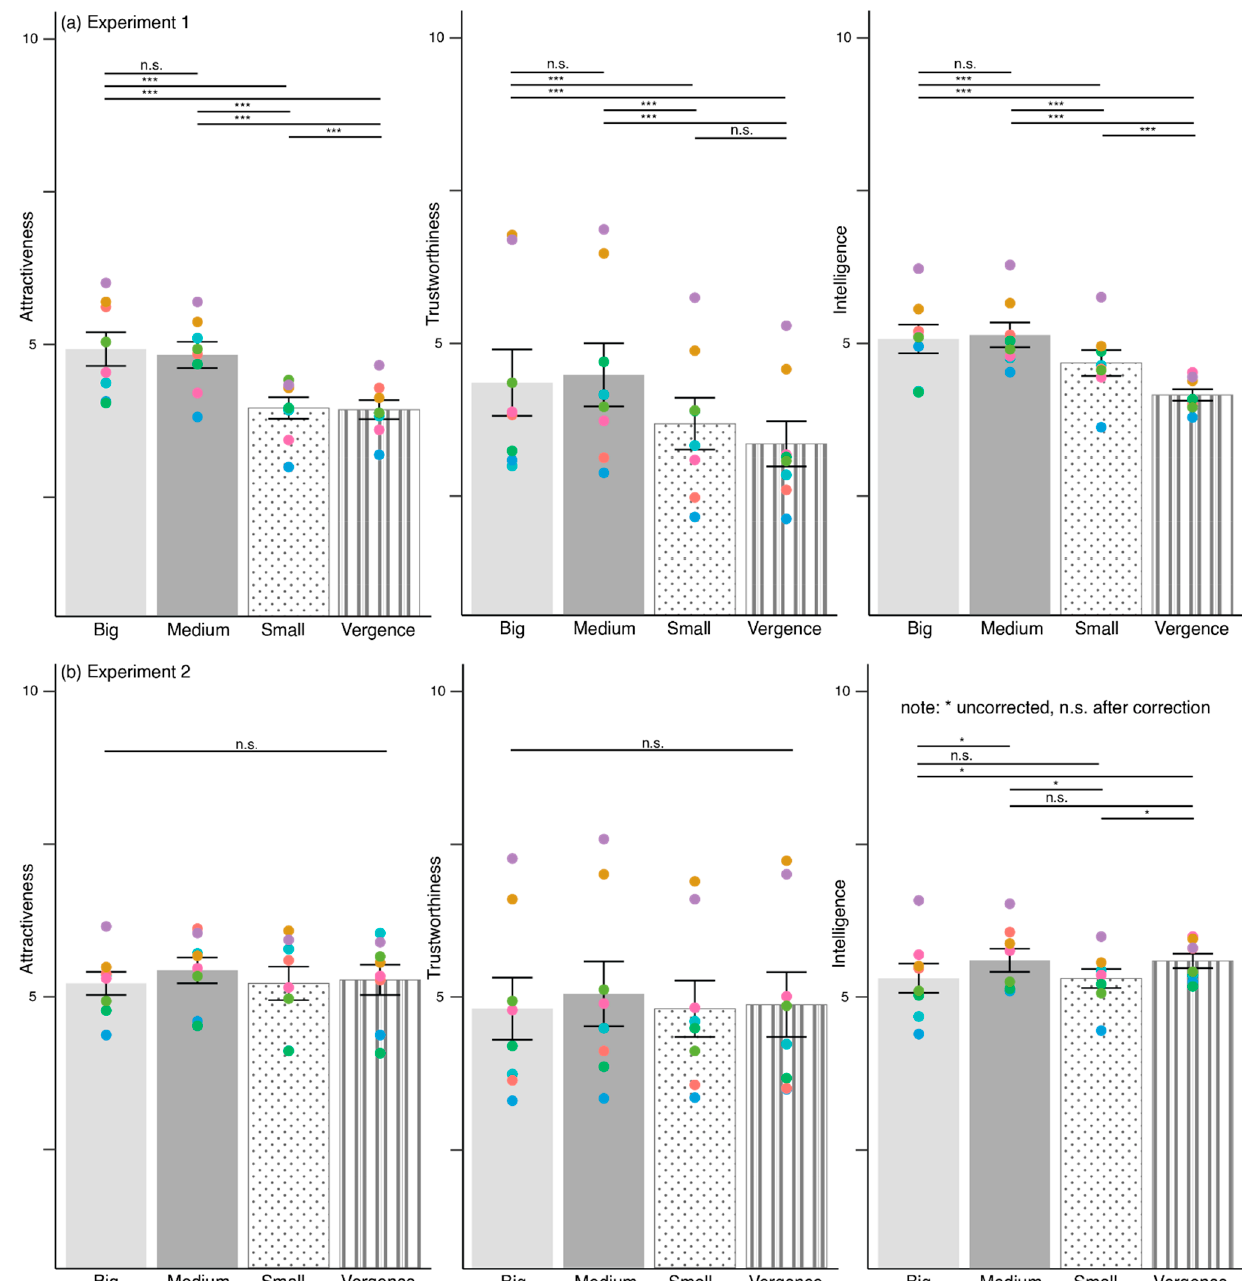
Figure 5. Attractiveness, trustworthiness, and intelligence ratings in ( a ) Experiment 1, and ( b ) Experiment 2 across big, medium, small, and vergence pupils. The colored scatter corresponds to each eye model. Error bars depict standard error of means, S.E.M. *** p < 0.001, * p < 0.05. Intelligence ratings in Experiment 2 are not significant after Bonferroni-correction ( p < 0.008). n.s.—non-significant.